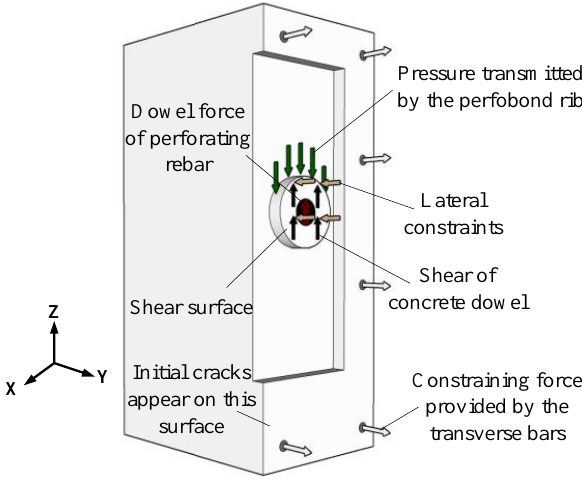
Figure 11. Force-transfer mechanism of the connector.